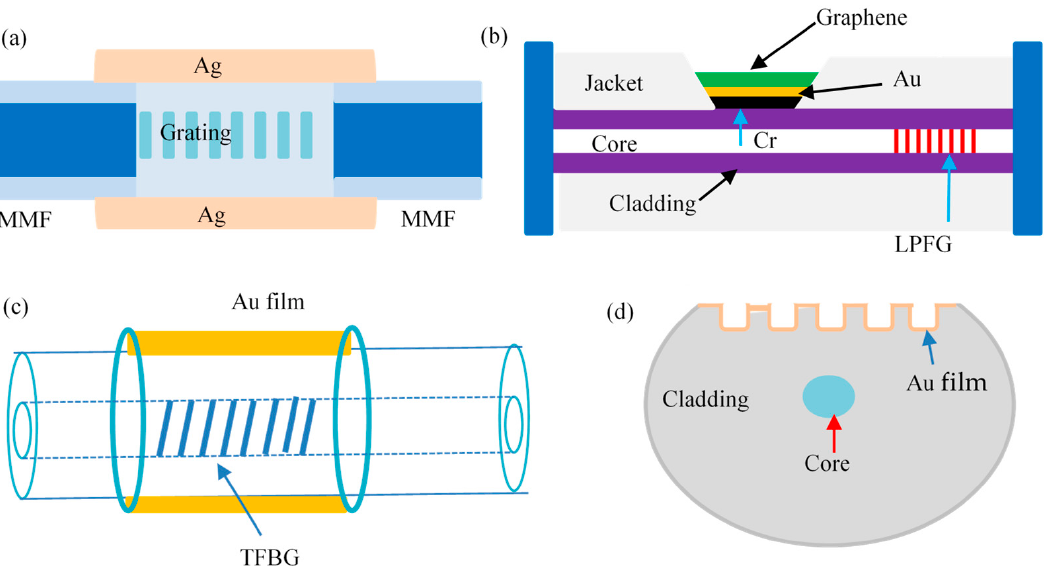
Figure 6. The structure of fiber grating sensing head ( a ) Bragg grating structure [61]; ( b ) long-period fiber grating structure [62]; ( c ) tilted fiber grating structure [63]; ( d ) surface grating structure [64].